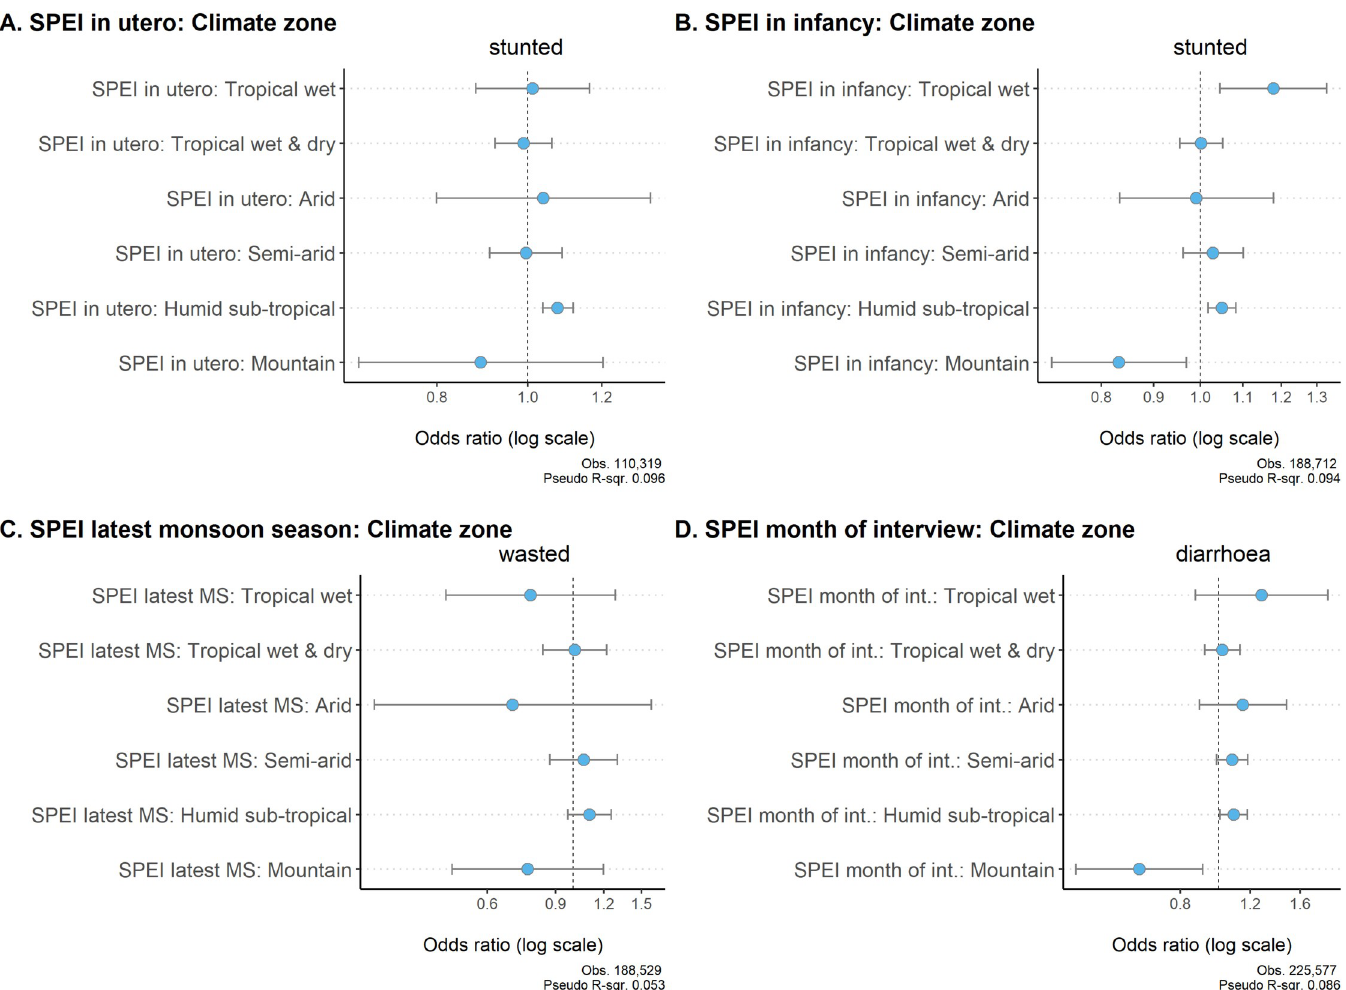
Fig 7. Effects of SPEI on undernutrition by climate zone, children aged 0–59 months. Figure shows odds ratios with 95% CIs. All control variables are included in the model but not displayed. Results are available in S9 Table in S2 Appendix.